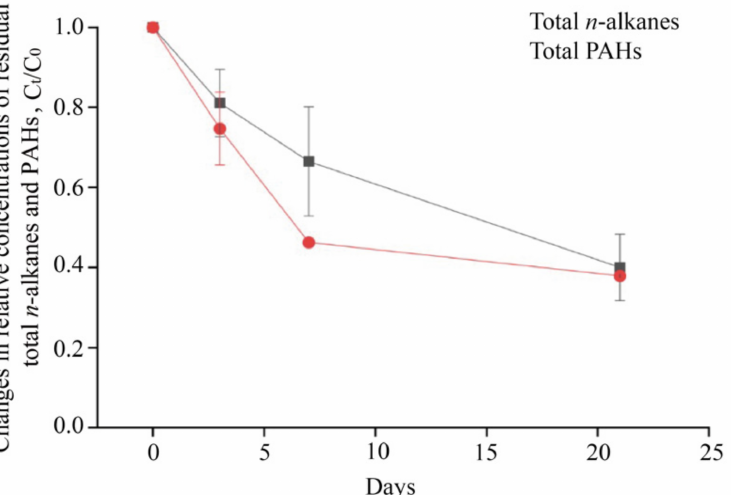
Figure 2. Changes in relative concentrations of residual total n -alkanes and PAHs incubation with diesel across the incubation in the diesel treatment. C t /C 0 represent the relative concentrations of total n -alkanes and PAHs, respectively, at different time point (C t ) compared to their concentrations determined at day 0 (C 0